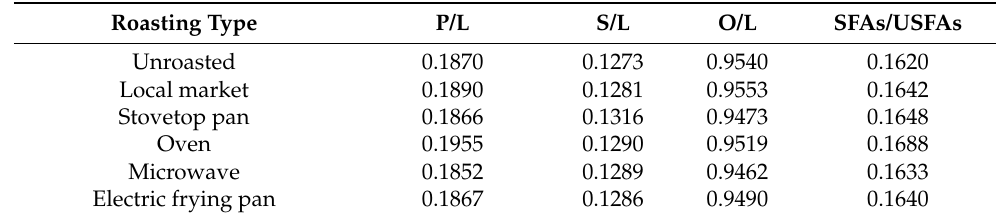
Table 3. Ratios of palmitic, stearic, and oleic acids over linoleic acid and SFA/USFA ratios of oil recovered from sesame seeds roasted with different methods.